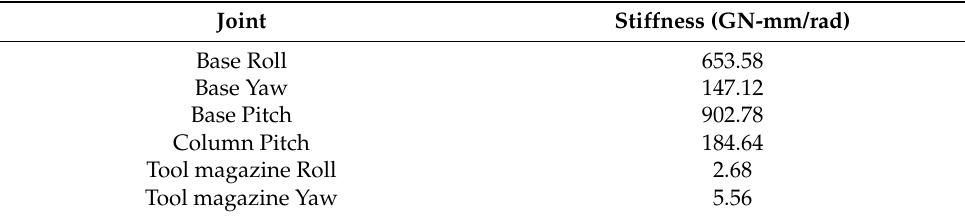
Figure 13. Dynamic model with identified joints. Table 4. Joint stiffness for each part in the movement